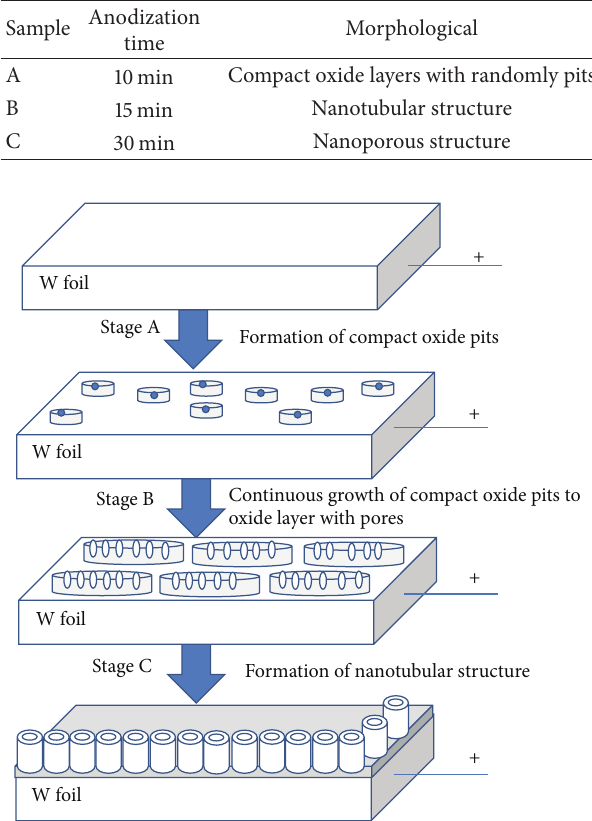
Figure 4: Schematic illustration of formation and mechanistic stud- ies of anodic WO 3 nanostructures obtained in 1M Na 2 SO 4 elec- trolyte containing 0.5 wt% NH 4 F for 15min at 40